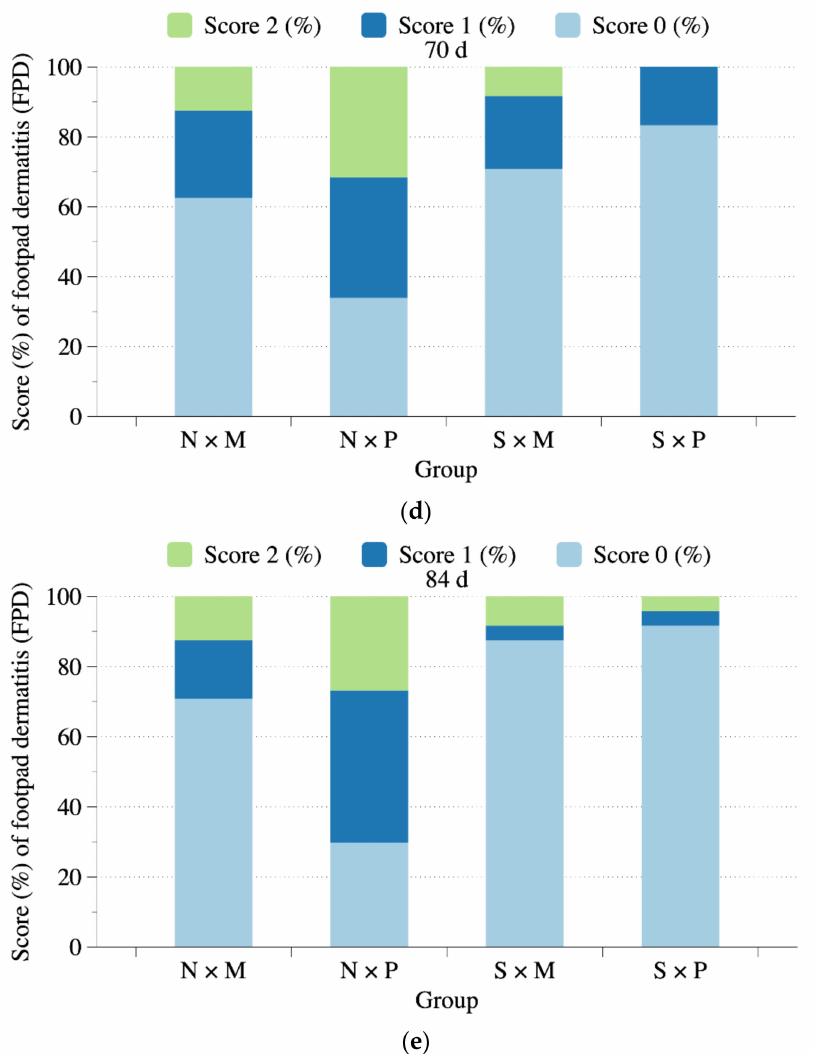
Figure 5. FPD score levels division (%) per treatment combination at 28 ( a ), 42 ( b ), 56 ( c ), 70 ( d ), and 84 ( e ) days of age as score 0 level (the score 0 to <0.5), score 1 level (the score 0.5 to <1.5), and score 2 level (the score 1.5 to <2.0). N × M: no swimming pool on the mud floor. N × P: no swimming pool on perforated plastic floor. S × M: swimming pool on the mud floor. S × P: swimming pool on the perforated plastic